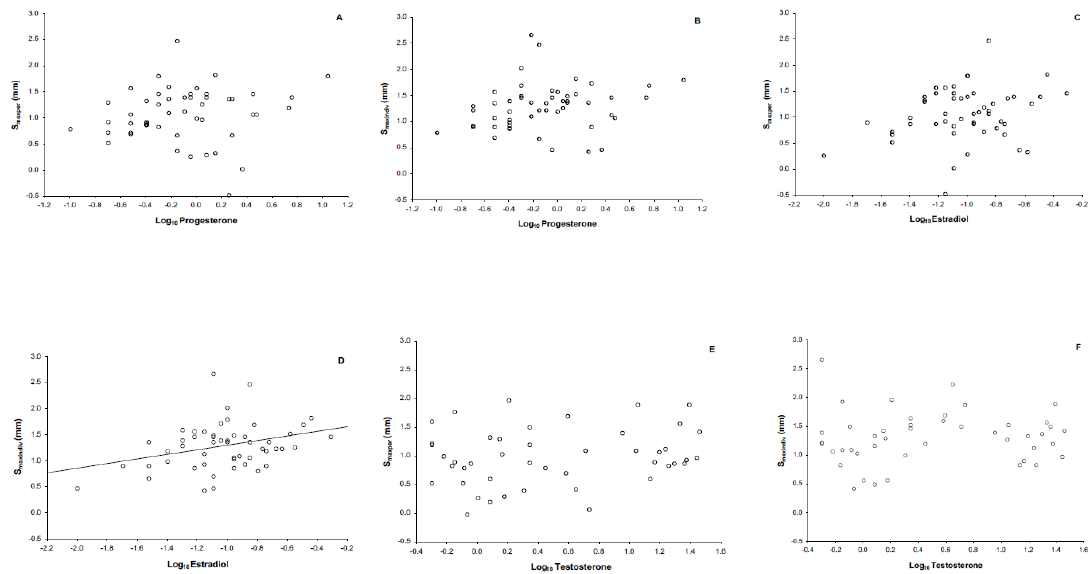
Figure 3. Pearson correlation analyses between swelling indices (S maxper and S maxindiv ) and steroid sex hormone concentration in female ( A – D ) and male ( E , F ) fish-eating myotis in Partida Norte Island, Mexico. The regression line is shown only when the correlation was significant.